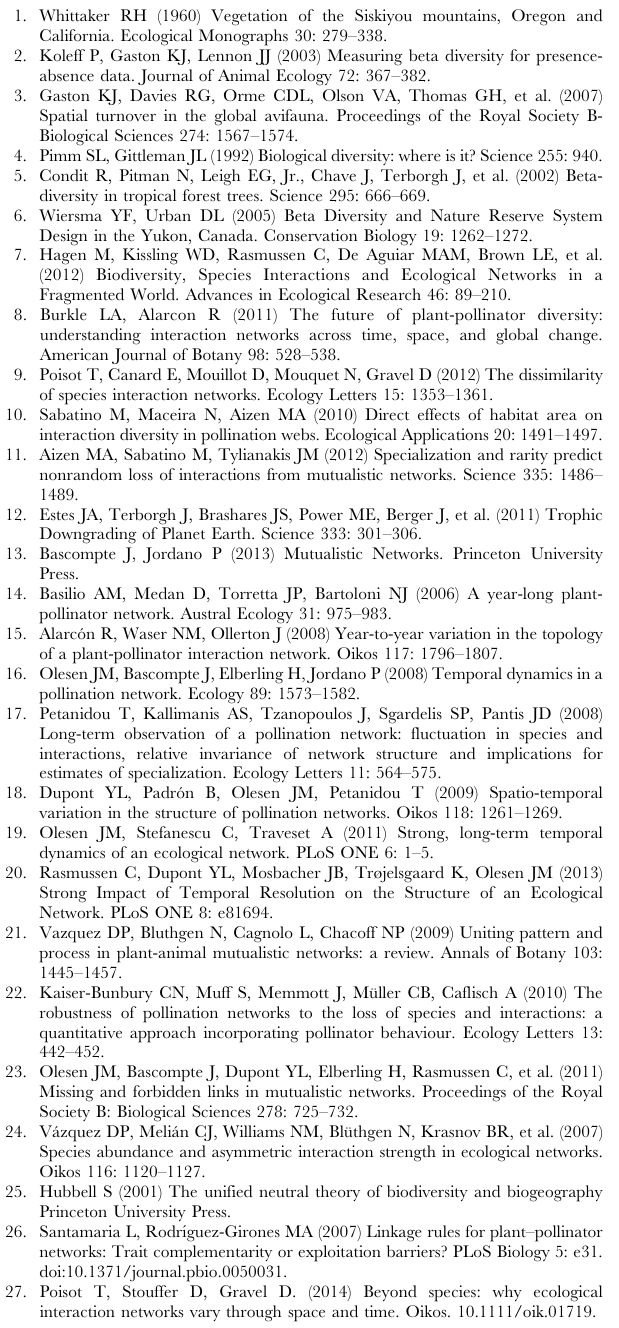
table mountains (Campo Rupestre) in Brazil. Vegetatio 113: 125–139. 43. Giulietti AM, Pirani JR, Harley RM (1997) Espinhaco Range region,